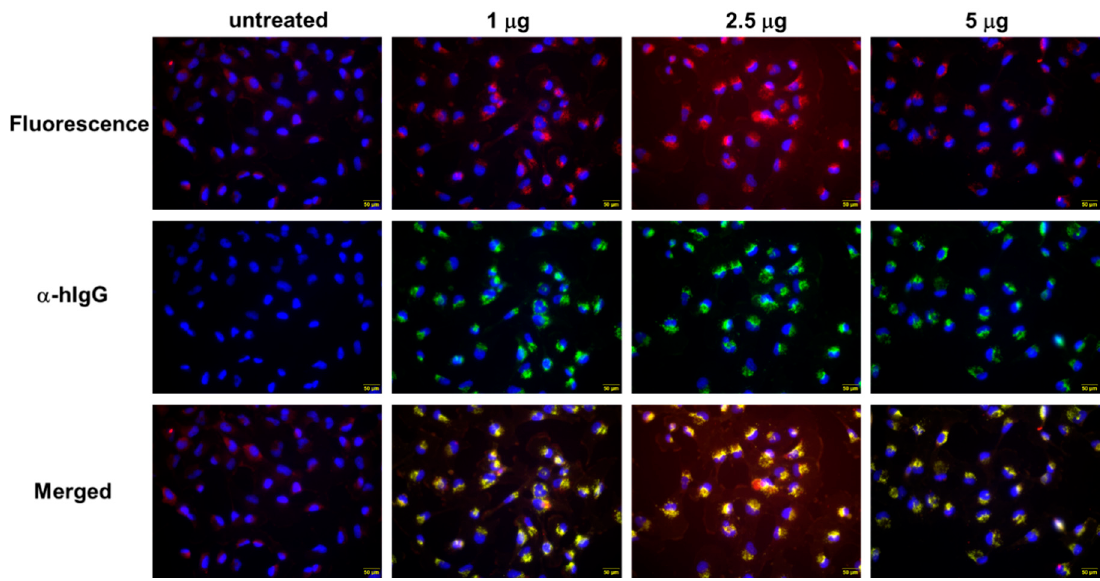
Figure 5. QUAD 3.0-WP936 binding and internalization to U-251 GBM cells. The cells were treated with 1.0–5.0 μ g of the conjugate for 4 h. WP936 was detected by red fluorescence in a TRITC channel and QUAD 3.0 by green fluorescence through Alexa-488-conjugated anti-human IgG. Sections were counterstained for DAPI (blue fluorescence) (scale bar: 50 μ m).